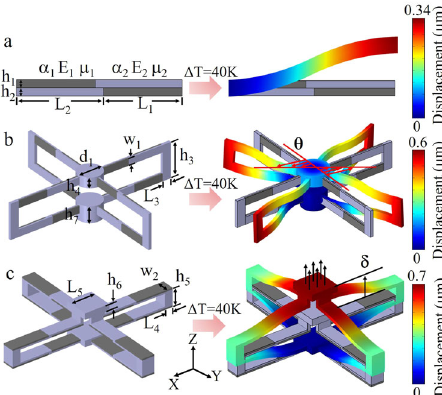
Fig. 1 Illustration of the operating principle of rotational and translational stages. a Bimaterial beam and its deformation under a change in surrounding temperature of 40K. b , c Operating principle of the translational and rotational elements, respectively. The component with higher (lower) CTE is depicted in blue (gray). The initial positions of the elements are outlined for visual comparison. The directions of rotation (translation) are indicated by red (black) arrows. For clarity, deformations in panel ( a ) and panels ( b , c ) are scaled by 10 times and 40 times, respectively. Key parameters marked in the panels are α 1 = 3.84× 10 − 5 K − 1 ,